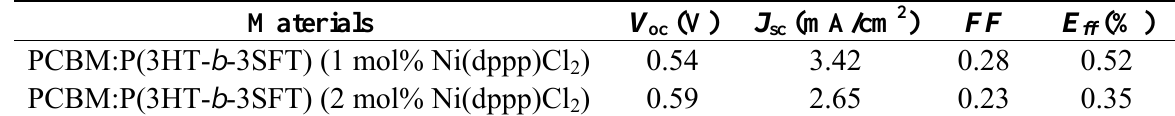
Table 3. The characteristics of polymer solar cells with P(3HT- b -3SFT).